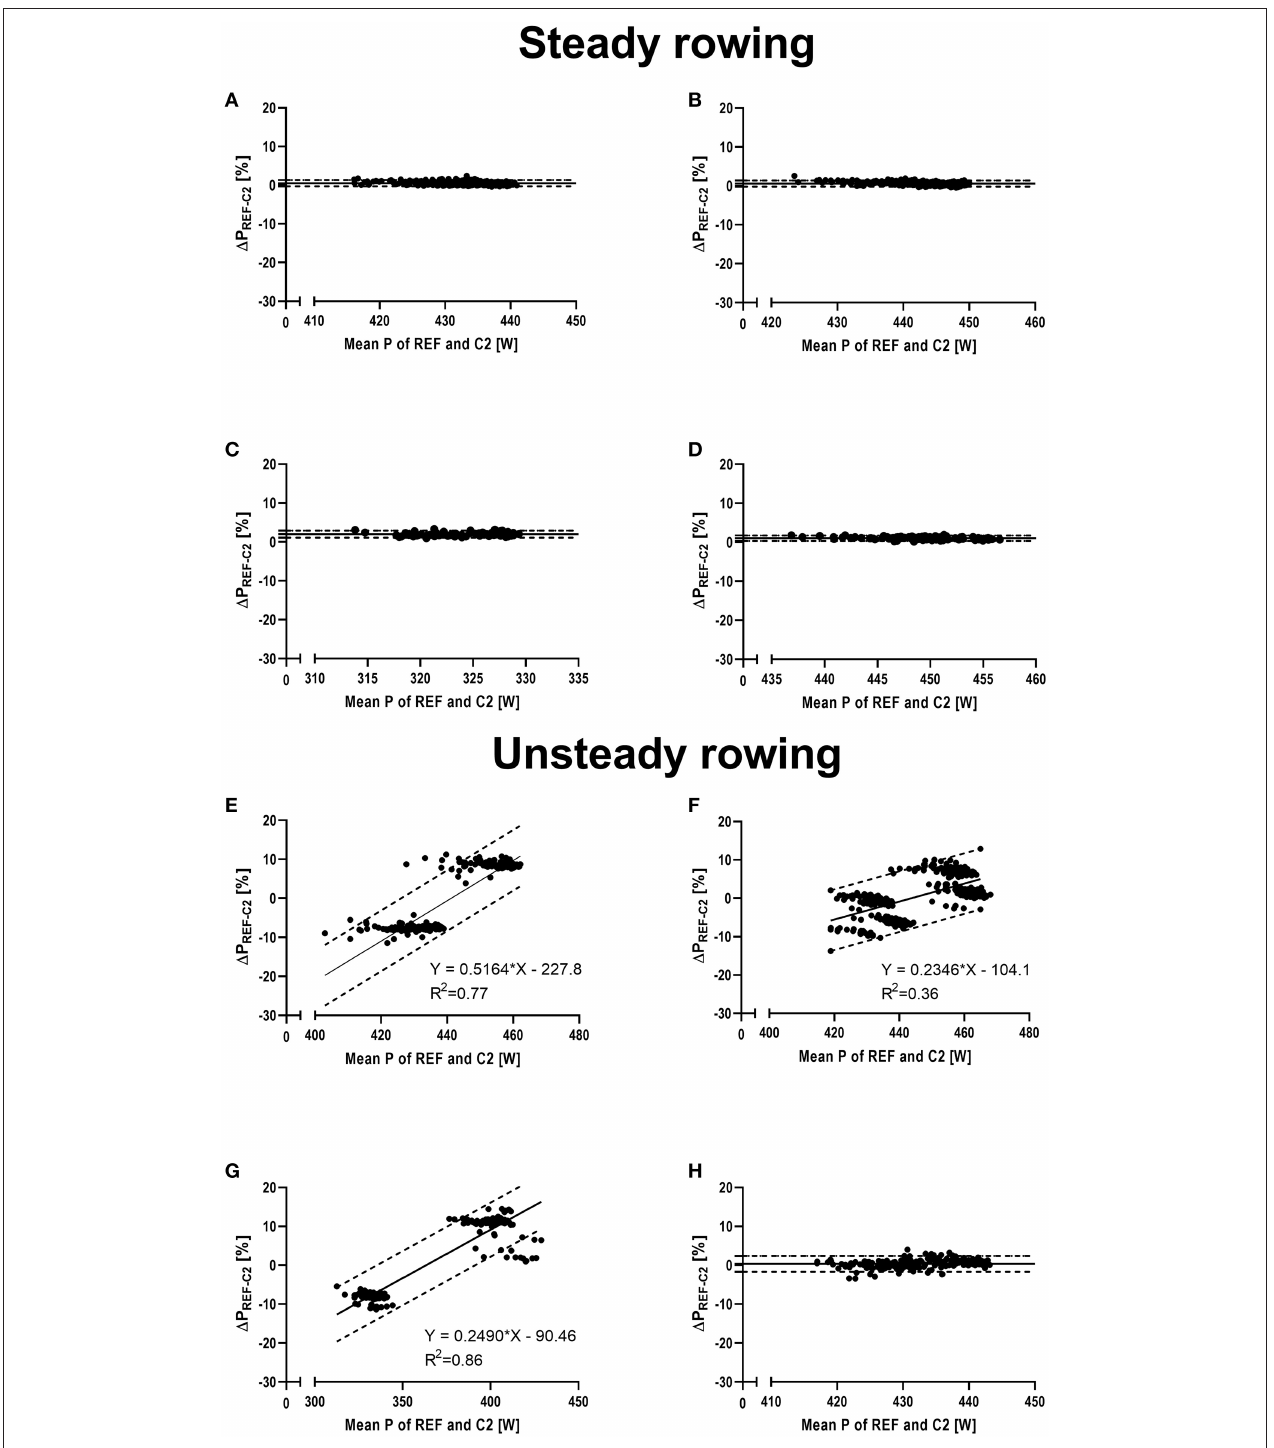
FIGURE 4 | Bland-Altman plots visualizing the percentage differences in mechanical power output between the reference system of a test rig for air-braked rowing ergometers and the Concept 2 Indoor Rower’s PM5 Monitor, shown on the y-axis ( 1 P [%]). The x-axis shows the mean mechanical power output (P) of both measurement systems. Solid line indicates mean difference and broken dotted lines indicate 95% limits of agreement or, in case of magnitude dependent differences, linear regression analysis and regression-based limits of agreement, respectively. (A) Steady rowing with mid-emphasized strokes (mid); (B) steady rowing with end-emphasized strokes (end); (C) steady rowing with a stroke rate of 22 min − 1 (SR-22); (D) steady rowing with a stroke rate of 28 min − 1 (SR-28); (E) unsteady rowing with high regularly alternating stroke force (ALT); (F) unsteady rowing with low randomly alternating stroke force (RND); (G) unsteady rowing with high regularly alternations in stroke rate (HV); (H) unsteady rowing with low randomly alternations in stroke rate (LV).